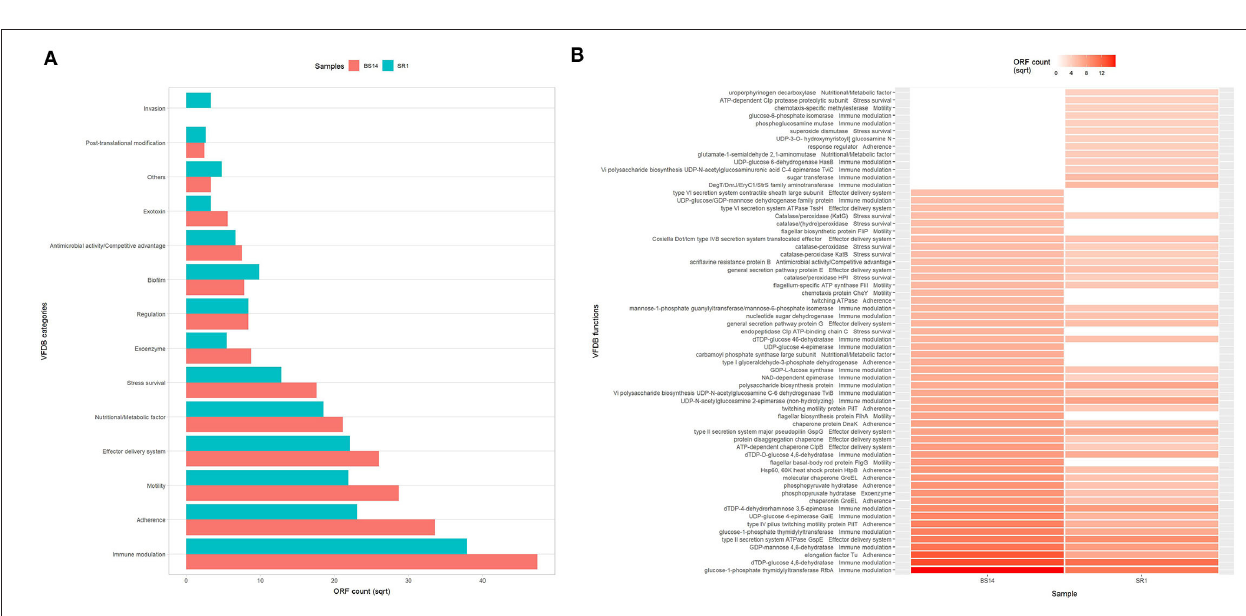
(10.6%), Shewanella (12.6%), Comamonas (5.3%), Aeromonas (0.81%), Pseudogemmobacter (0.69%), Fluviibacter (0.93%), Acidovorax (2.8%), Polynucleobacter (0.36%), Azoarcus (0.3%), and Flavobacterium (0.25%) ( Figure 5B